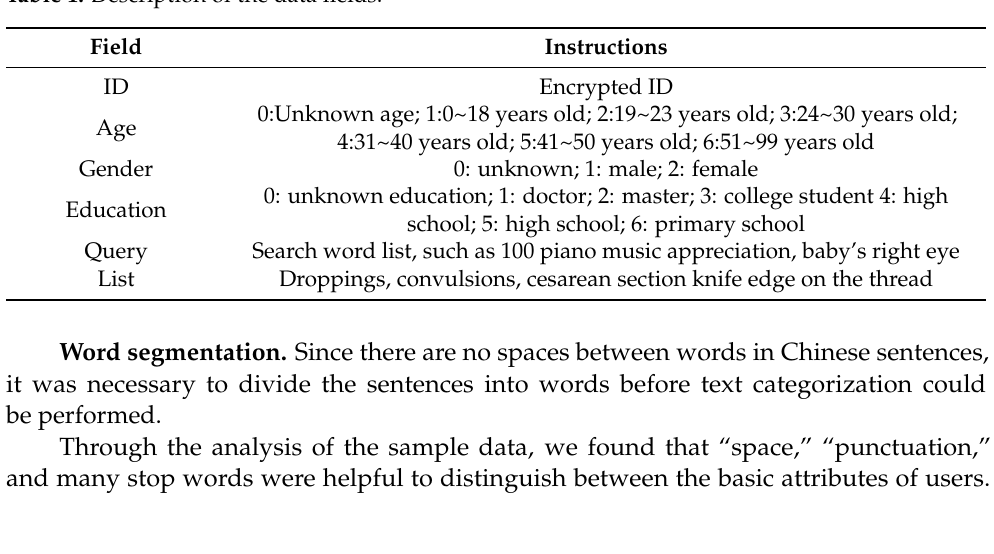
Table 1. Description of the data